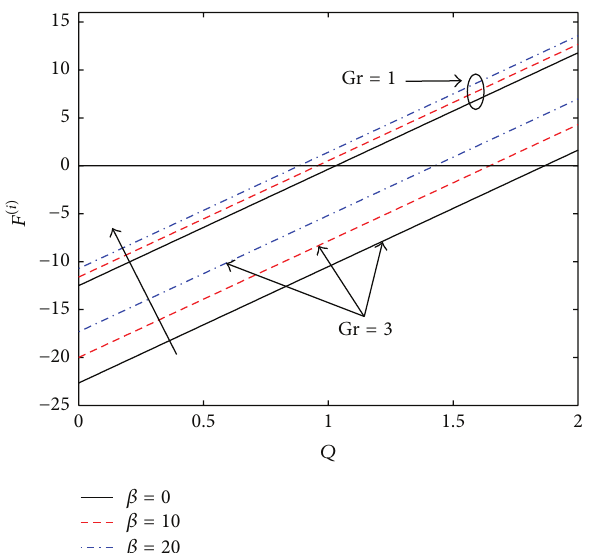
Figure 10: Frictional force on the inner tube 𝐹 (𝑖) versus the time- averaged flow rate 𝑄 for different values of the parameter 𝛼 1 and amplitude ratio 𝜙 with Gr = 3 , 𝜀 = 0.35 , 𝛽 = 10 , 𝜆 1 = 1 , and 𝑡 = 1